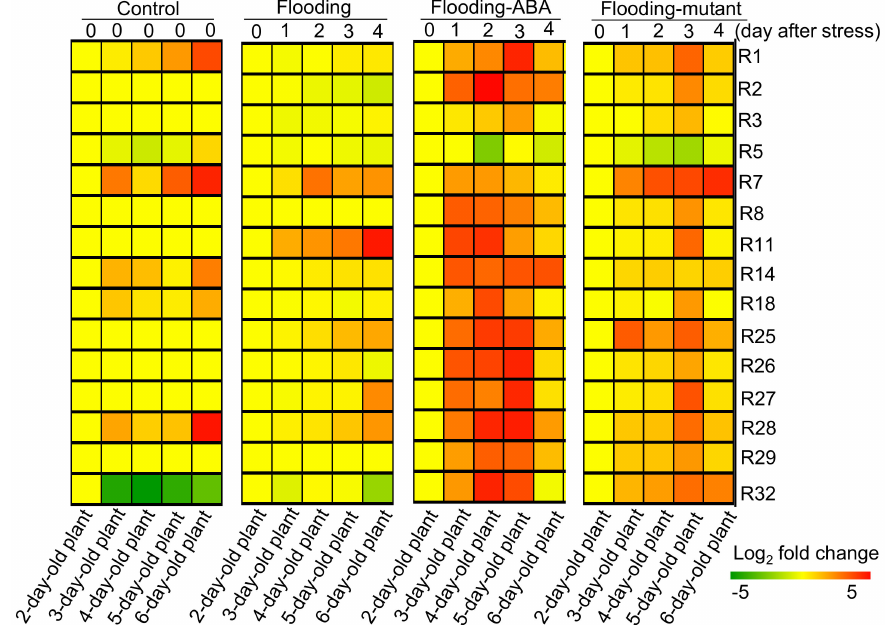
Figure 4. Cluster analysis of proteins related to glycolysis, fermentation, and tricarboxylic acid